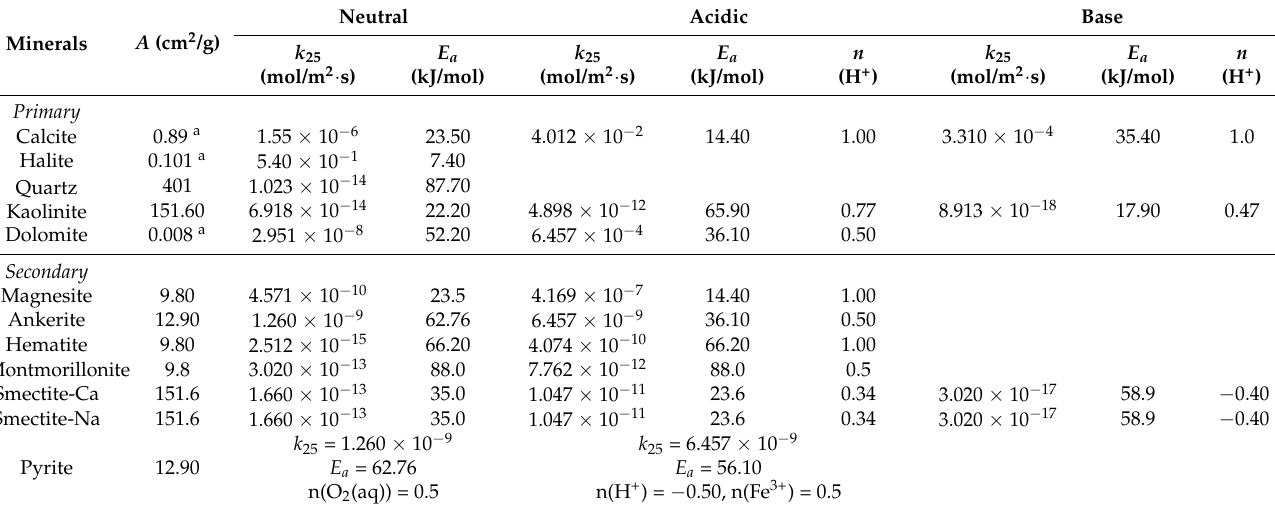
Table 4. Summary of primary and secondary mineral species and their kinetic